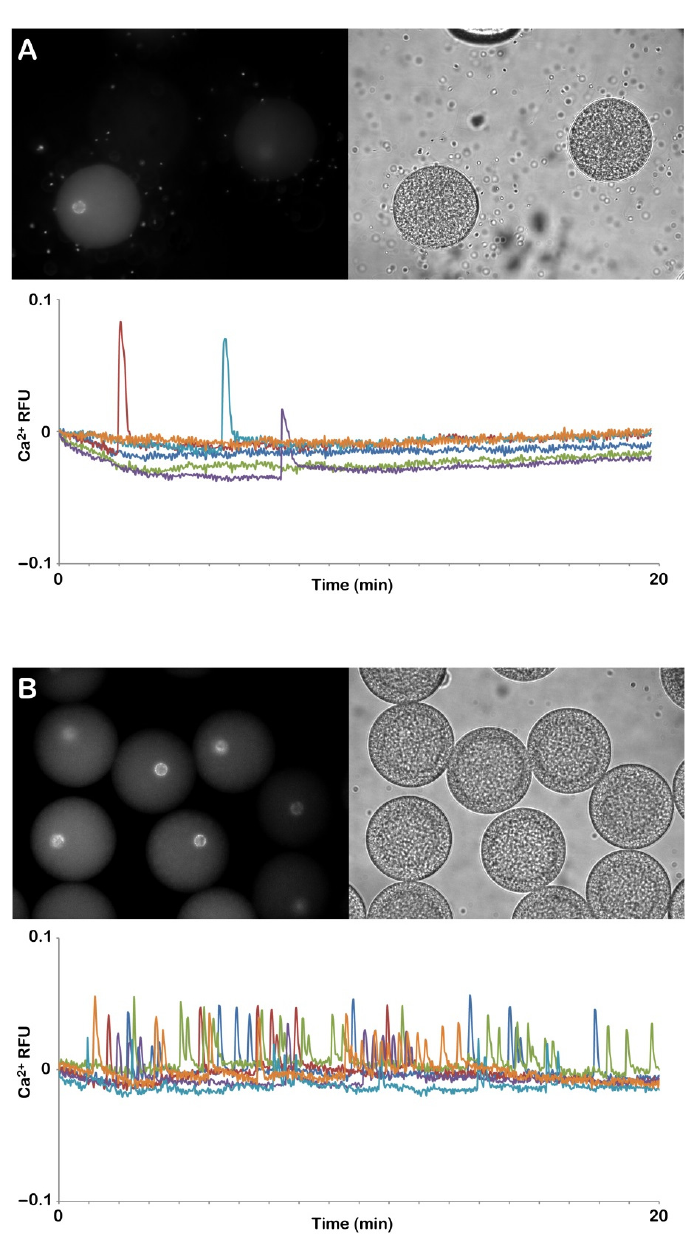
Figure 5. Comparison of the cross-fertilization between whole P. lividus and denuded eggs with Arbacia lixula sperm. ( A ) The fluorescent and transmitted light images show A. lixula sperm embedded in the jelly layer surrounding P. lividus eggs 5 min after insemination. The graph shows the measurement (20 min) of the Ca 2+ changes following the interaction between gametes during heterologous fertilization. The first CF following the interaction of A. lixula sperm with the intact P. lividus eggs was detected around 5 min after the sperm addition. No Ca 2+ signals were transduced by heterospecific sperm in 14 of 17 eggs. ( B ) Insemination of denuded P. lividus eggs with A. lixula sperm elicited transient and small Ca 2+ changes only after the addition of sperm set at time 0, probably due to the mechanical stimulation of the sperm to the egg surface. RFU = relative fluorescence unit.